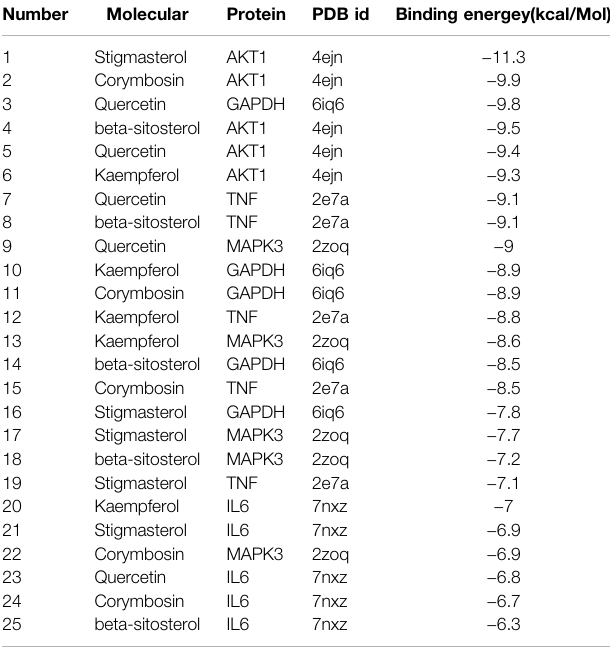
TABLE 2 | Molecular docking binding